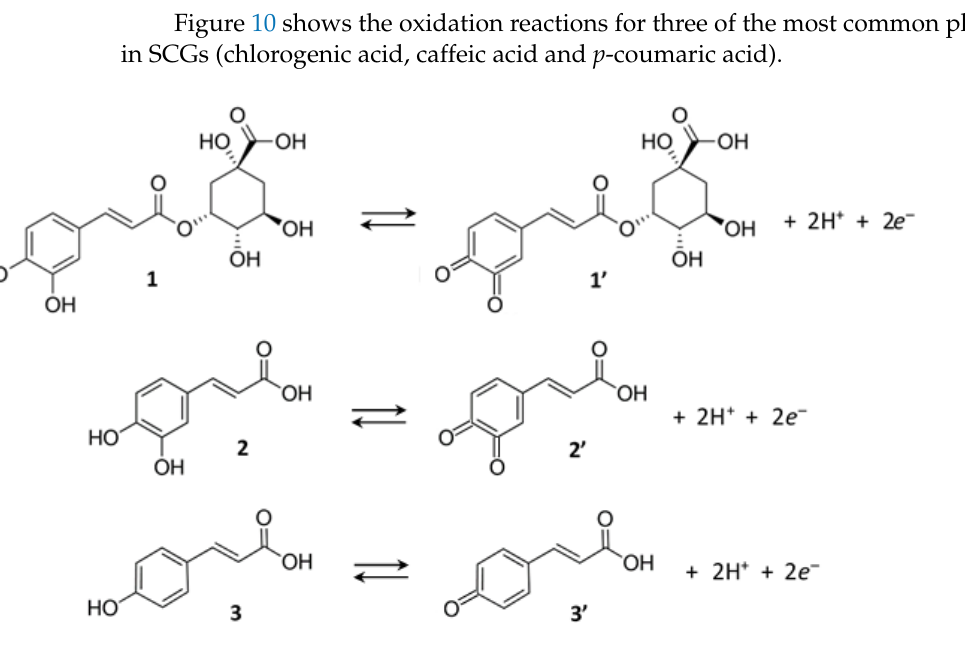
Figure 10. Oxidation of chlorogenic acid (1), caffeic acid (2) and p -coumaric acid (3) to their corre- sponding quinone forms (1 ′ , 2′ and 3′ ). sponding quinone forms (1 (cid:48) , 2 (cid:48) and 3 (cid:48)